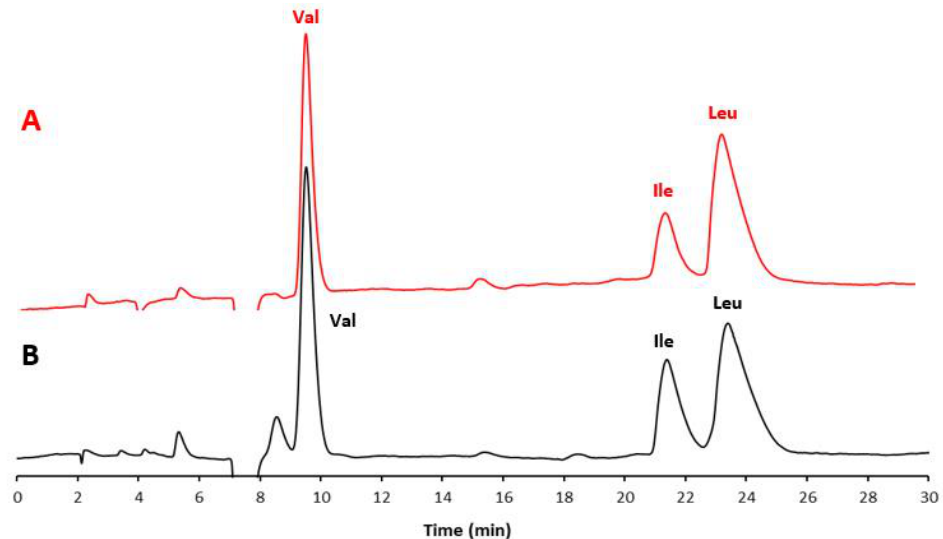
Figure 1. Chromatograms of ( A ) the mixture of three AA standards (red line) and ( B ) the extract from the selected food supplement (black line). Experimental conditions: column, Prevail RP18 (Grace, Sedriano, Italy) (250 mm × 4.6 mm i.d., 5 μm, 110 Å pore size); mobile phase, water/EtOH/HFBA (95:5:0.1, v / v / v ; HFBA concentration corresponding to 7 mM); column temperature, 25 °C; flow rate, 1.0 mL/min; UV @ 220 nm.